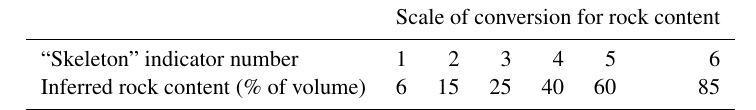
Table 2. The relationship between the coarse fragment (rock content and shape) indicator from the soil map encoding and the rock content as a percentage of the total volume. We used the average of each defined range.